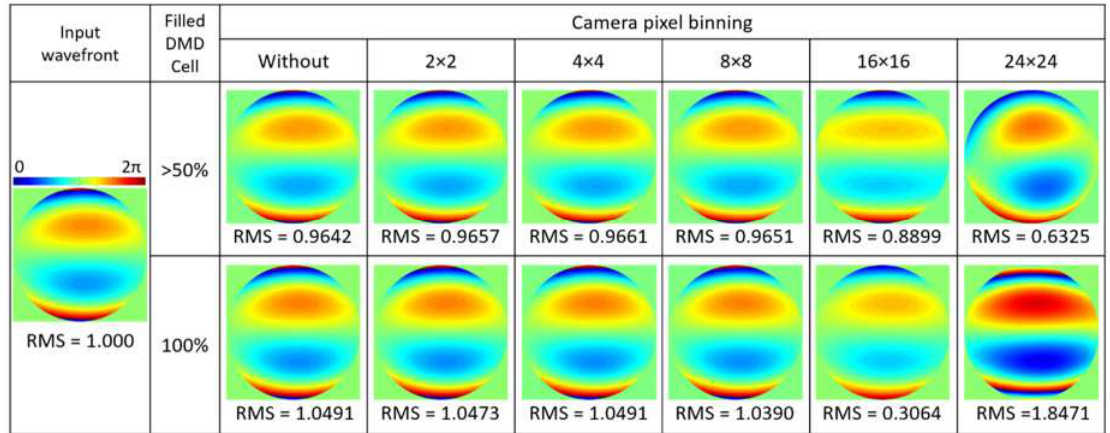
Figure 2. Comparison of wavefront reconstructions of a simulated wavefront with astigmatism, coma, and trefoil. First, using DMD cells which are at least 50% illuminated with a 4 mm beam, and second, those 100% illuminated by the incoming beam. For each case, the effect of square pixel binning of × 2, × 4, × 8, × 16, and × 24 pixels in the detector camera is compared. All root-mean-square (RMS) values are given in μm.